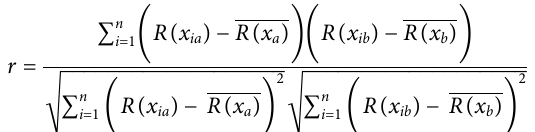
Frontiers in Environmental Science |